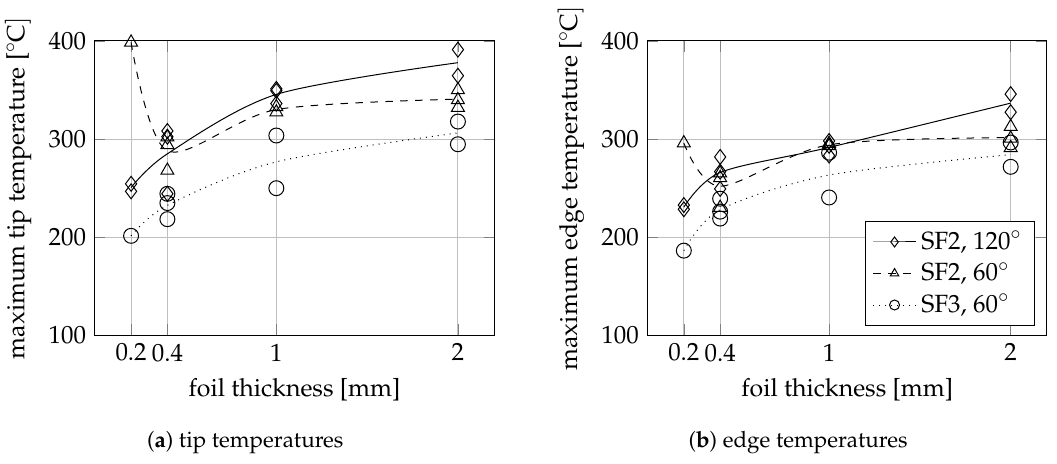
Figure 15. Average measured foil temperature at the fin tip and on the edge over foil thickness for rub scenario S3, both seal fin geometries and foil